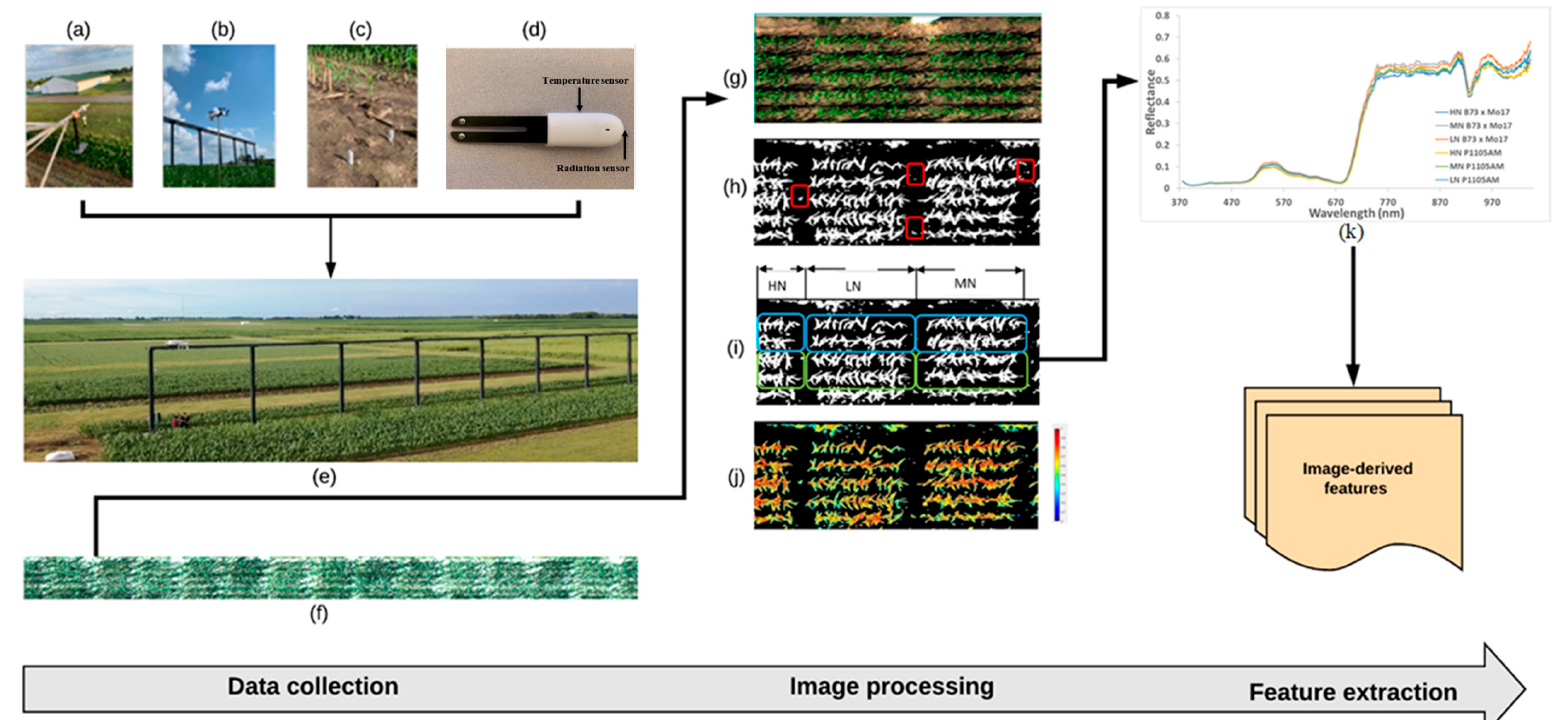
Figure 1. Field VNIR hyperspectral platform at Purdue University. ( a ) VNIR hyperspectral imaging sensor; ( b ) Local weather station (Ambient Weather, Chandler, AZ, USA); ( c , d ) Xiaomi flower care sensor (Xiaomi Inc., Beijing, China); ( e ) the layout of the east–west orientated imaging system; ( f ) image sample of the whole field; ( g ) enlarged image sample of part of the field; ( h ) binary image after segmentation; ( i ) layout of the plots with three nitrogen treatments and two genotypes. The green boxes were for Genotype P1105AM, and the blue boxes were for Genotype B73 × Mo17. Nitrogen treatments of HN, MN and LN were also labeled; ( j ) NDVI heatmap; ( k ) the spectra from different genotypes and nitrogen treatments.